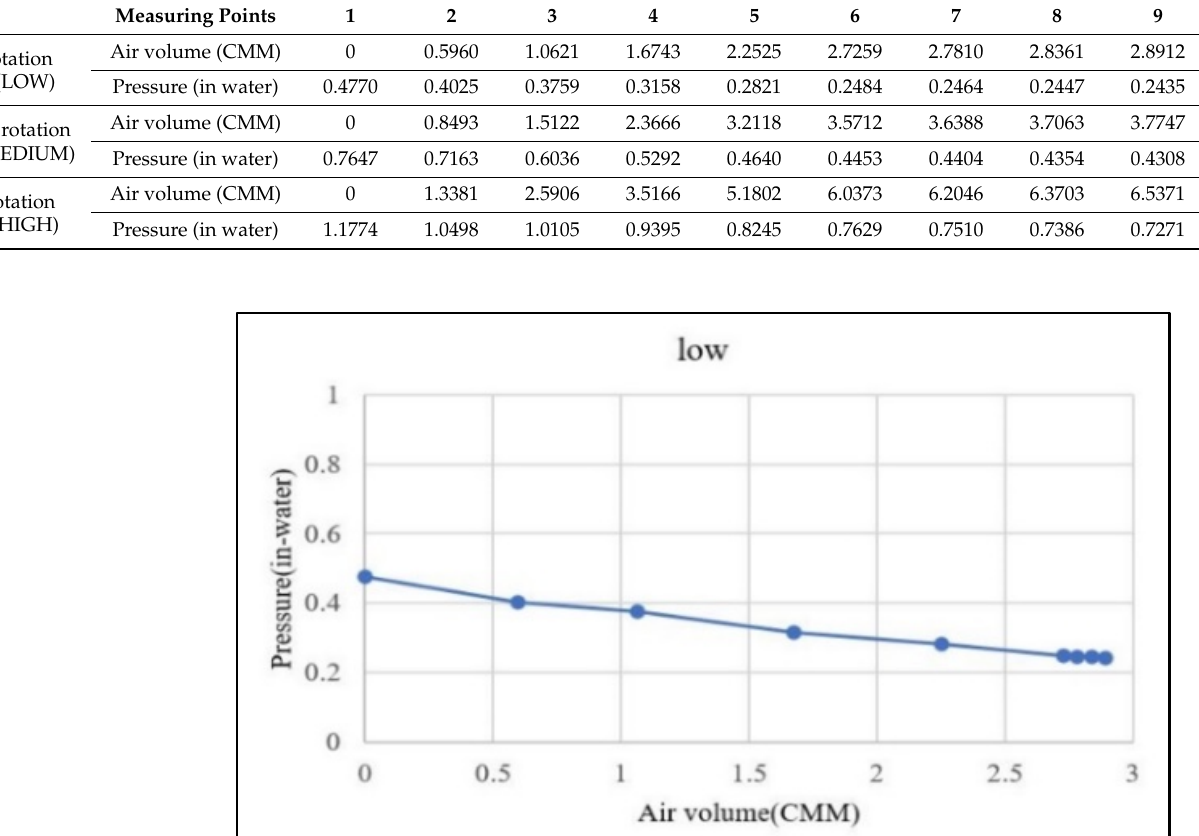
Figure 9. P-Q curve of the air purifier at a low rotation speed.